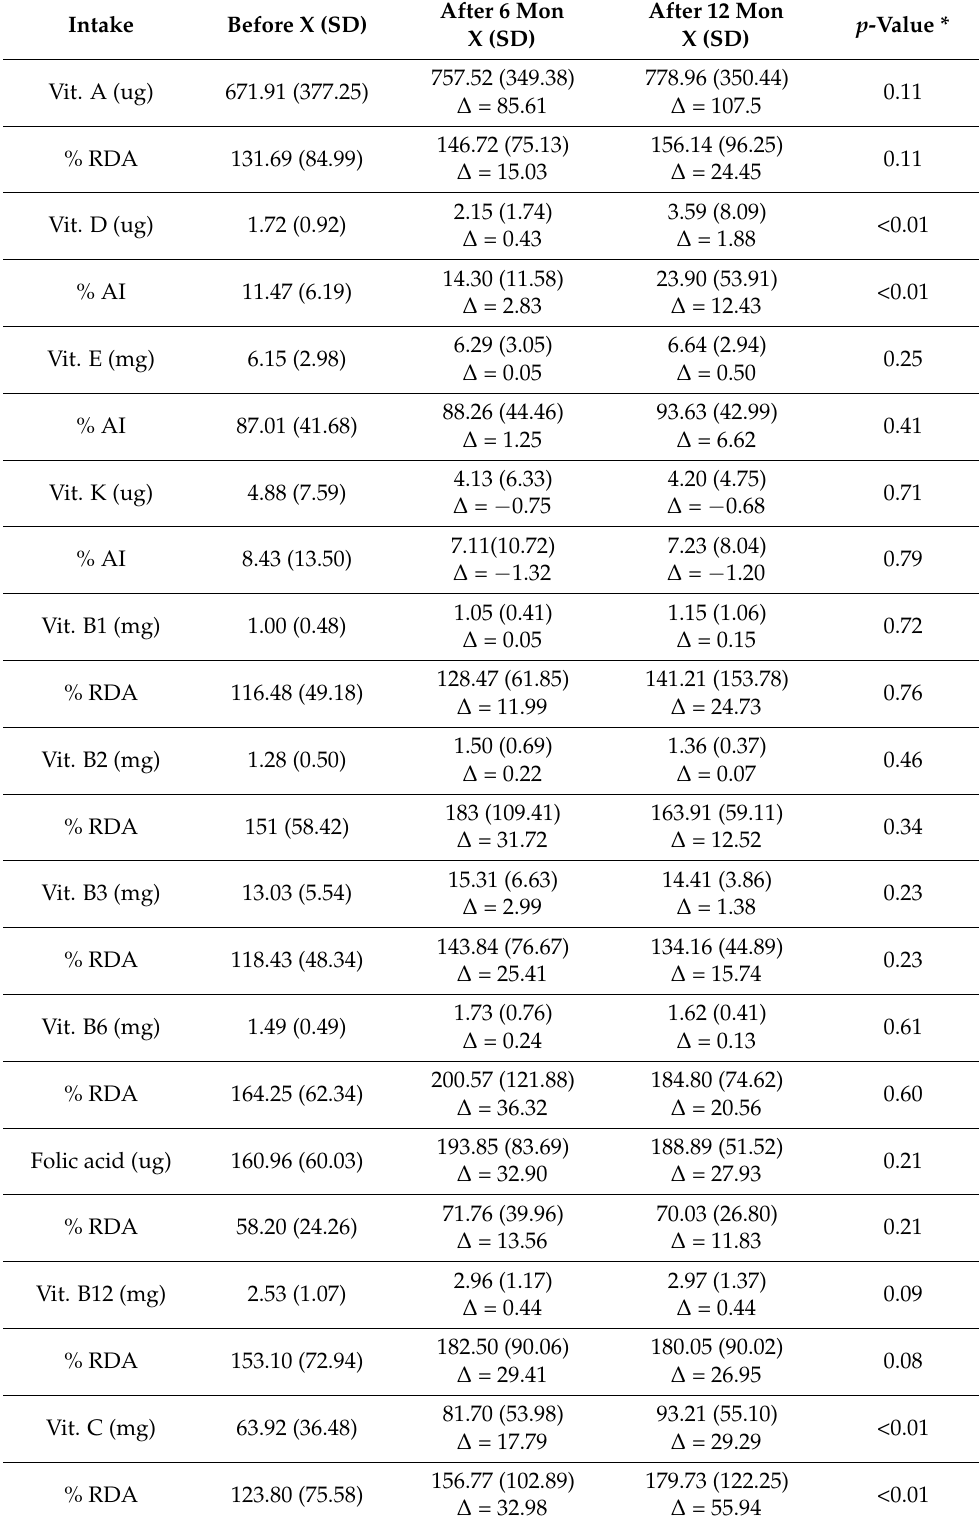
Table 5. Daily dietary intake and norm implementation of vitamins in the studied